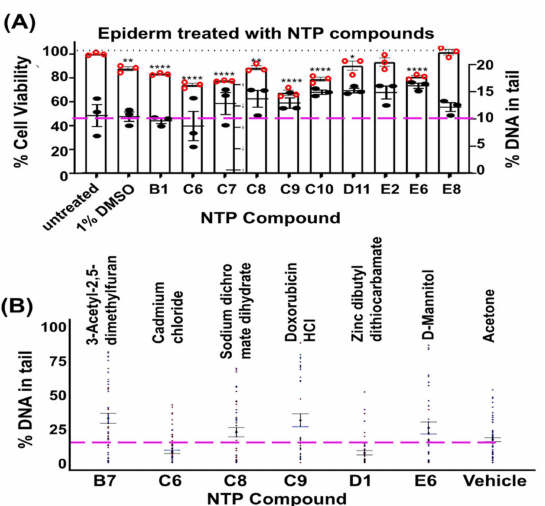
Figure 6. EpiDerm exposed to DNA-damaging agents. EpiDerm was topically exposed to each of the NTP compounds indicated. ( A ) Cell viability is shown as a histogram, with values on the left y -axis. % DNA in tail is overlaid as a 95% CI dot plot ( n = 3), with values on the right y -axis, and a dashed line showing the value for vehicle control (10% DNA in tail). ( B ) Percent DNA in tail repeated for additional compounds, with dashed red line showing the value for vehicle control. *, **, and **** represent p values < 0.05, 0.01, and 0.0001,